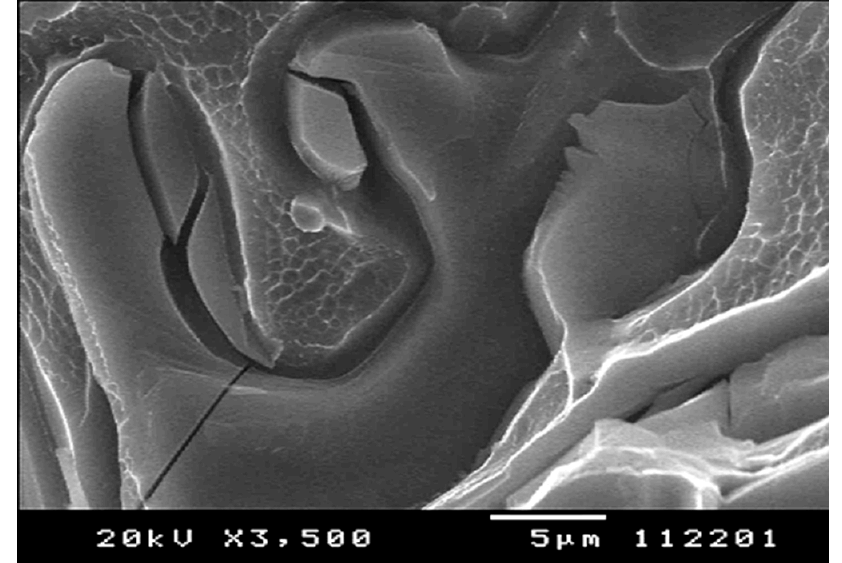
Figure 6. Fractured Si particles in an aerospace D357 aluminum alloy casting [102].